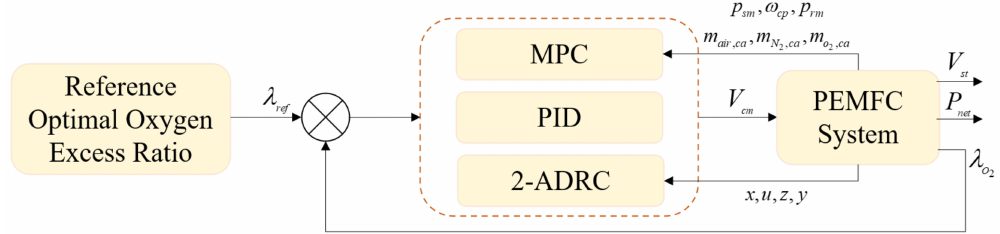
Figure 4. Control structure of air supply